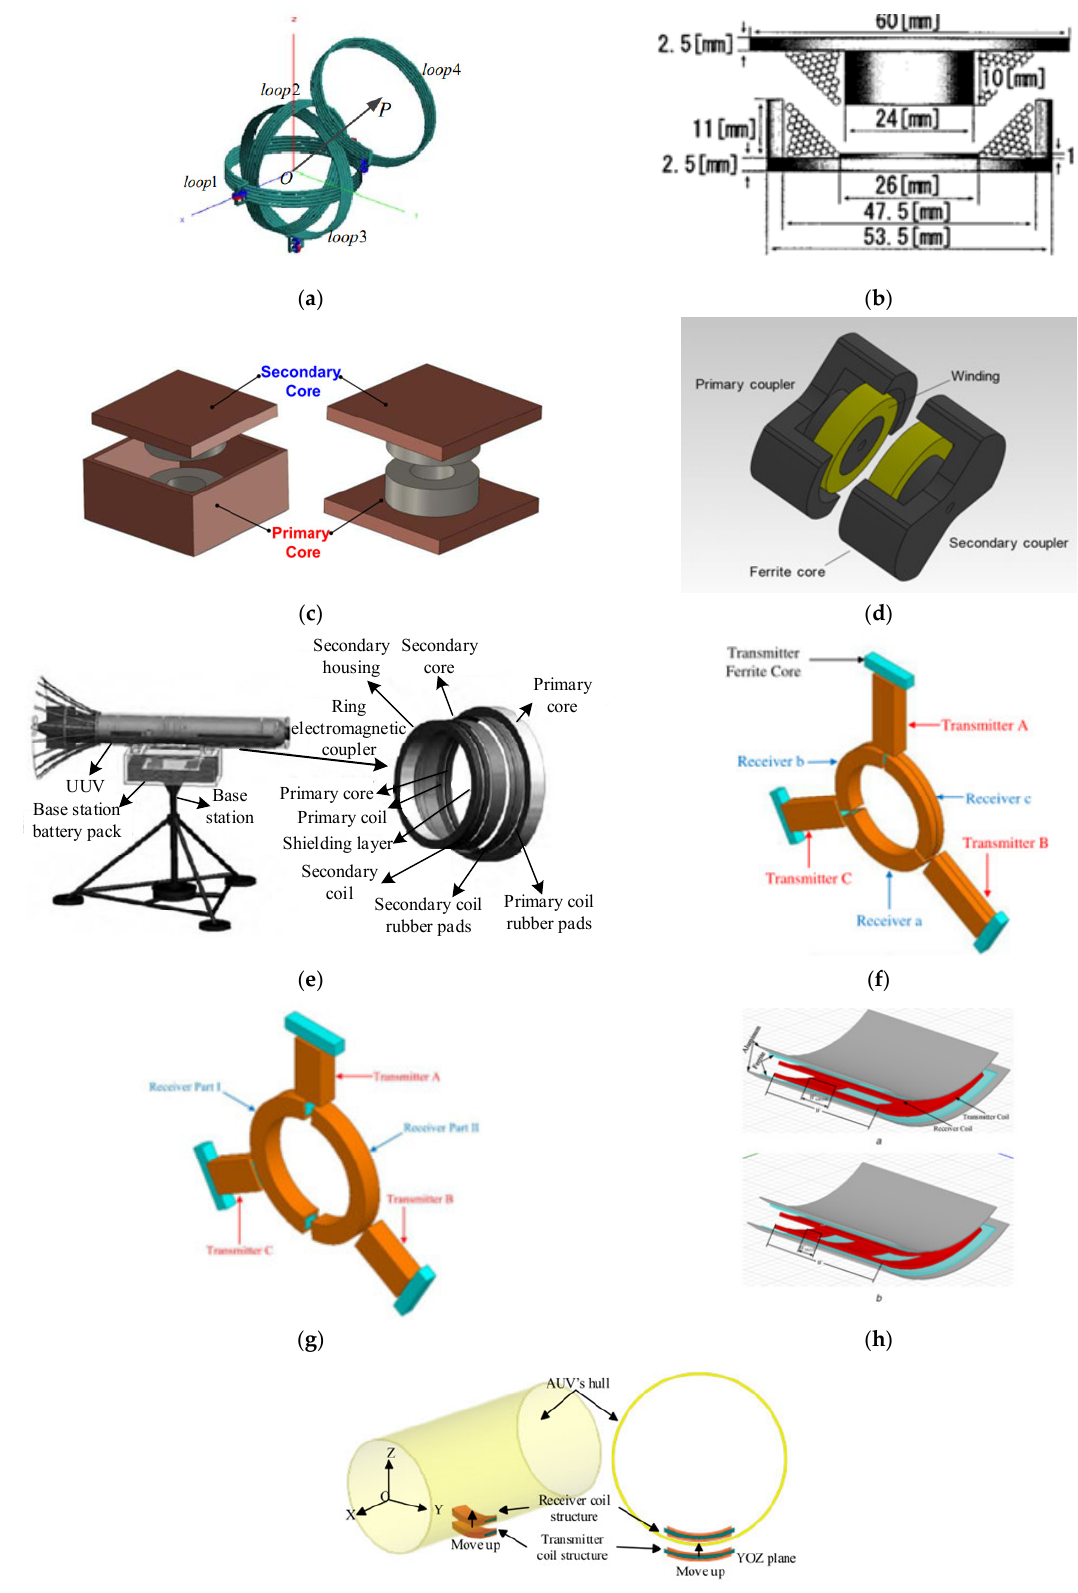
Figure 3. Types of electromagnetic couplers. ( a ) Three-phase coils; ( b ) Special electromagnetic coupler and tapered coils. ( c ) LCT semi-enclosed electromagnetic coupler; ( d ) PM type electromagnetic coupler. ( e ) Ring magnetic coupler; ( f ) Three-phase electromagnetic coupler; ( g ) Improved three-phase electromagnetic coupler; ( h ) Coiled coil electromagnetic coupler; ( i ) Dipole coil electromagnetic coupler.